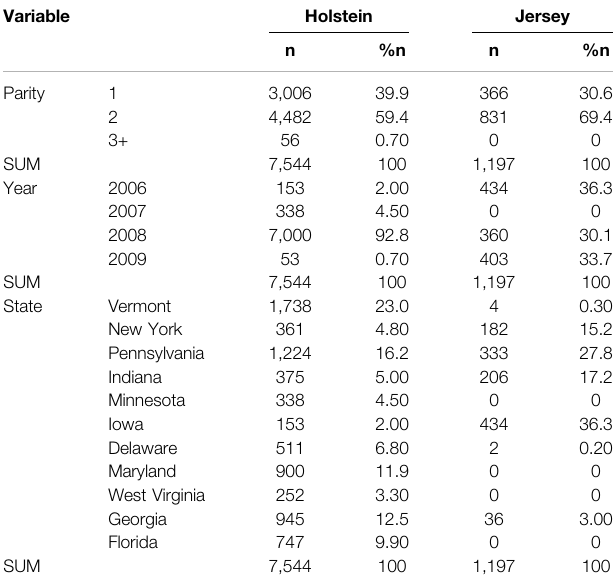
TABLE1| Number(n)andpercentage(%n)ofmilkingrecordsbyparities,lactation years, and states in the Holstein and Jersey cattle, respectively.